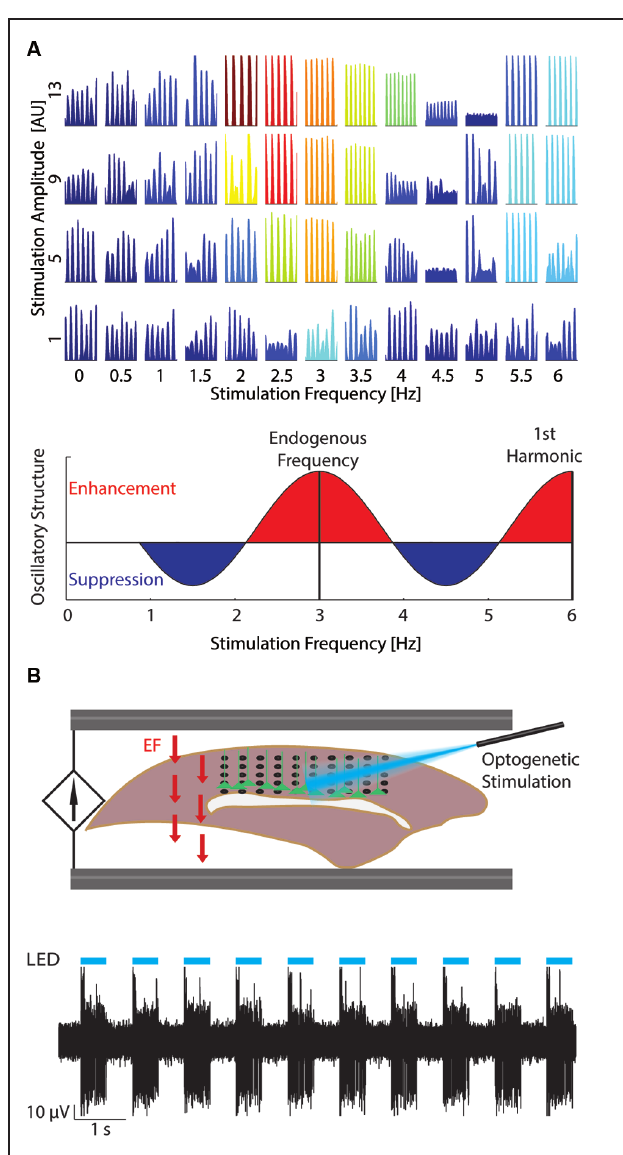
FIGURE 2 | Studying resonance dynamics with large-scale computational models and optogenetics . (A) Top: Network response to varying stimulation amplitude (increasing bottom to top) and frequency (left to right). Color indicates power of network activity at the stimulation frequency. At low stimulation amplitudes, the network was most entrained by stimulation at the endogenous frequency ( ∼ 3 Hz). Increased stimulation amplitude expanded the stimulation frequencies that entrained the network. Reprinted with permission (Ali et al., 2013). Bottom: Change in oscillatory structure for increasing tACS frequency. Red areas represent relative enhancement of oscillatory structure with maxima at the endogenous oscillation frequency and harmonics of the endogenous oscillation. Blue areas represent relative suppression with minima between harmonics of the endogenous oscillation. (B) Top: Experimental set-up (Schmidt et al., 2013). Optogenetic stimulation (blue) is applied to layer V pyramidal cells (green) from above to entrain the network at the desired frequency. EF (field arrows, red) is then applied through AgCl wires to model the effect of TCS. Neural data may then be recorded, for example with a multielectrode array pictured here (black). Bottom: Example multiunit trace (black) displaying strong entrainment to the optogenetic stimulation (cyan). Reprinted with permission (Schmidt et al.,